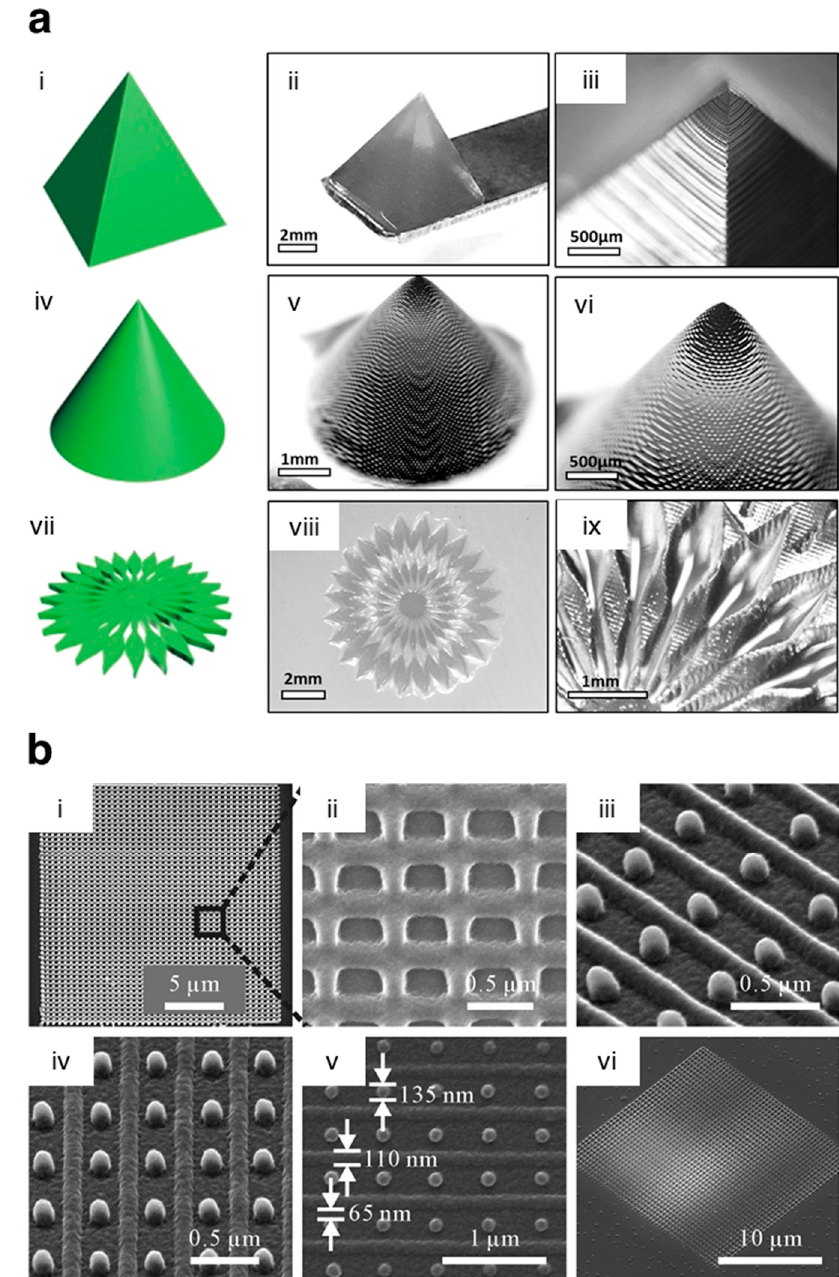
Figure 14. High-resolution 3D printing. ( a ) Solid hydrogel constructs generated by lithography-based biofabrication by DLP: ( i – iii ) pyramid, ( iv – vi ) cone, ( vii – ix ) flower with channels ranging from 50 μ m to 500 μ m. Adapted with permission from [342]. Copyright © 2018, IOP Publishing Ltd. ( b ) SEM images of high-resolution periodic structures fabricated via two-photon polymerisation, consisting of parallel lines and vertical pillars. By adjusting the laser focus during the printing process, it was possible to transition between undefined structures, in which the lines and the pillars were not distinguishable ( i , ii ), to well-defined periodic arrays, where the pillar and line organisation was well discernible ( iii – v ). ( vi ) displays the entire 3D-printed array. Adapted from [347] under